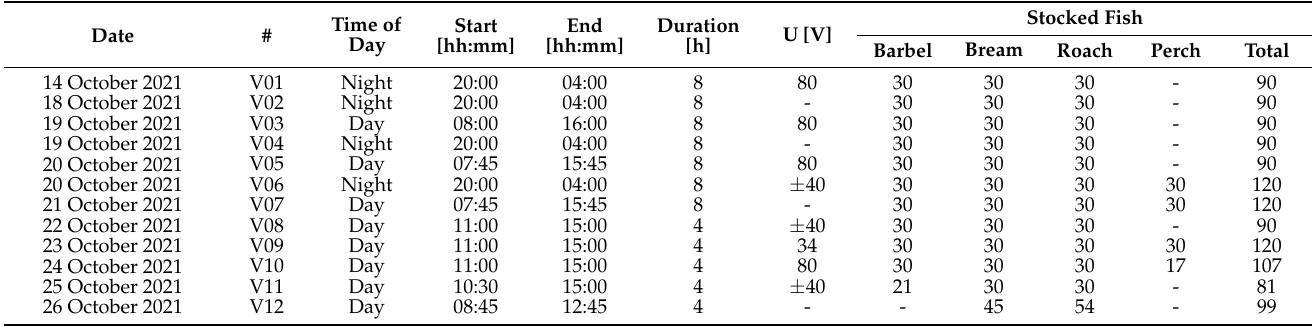
Table A1. Conducted trials including main parameters, date, trial number, time of day, start and end-time, duration, treatment conditions U (voltage) and stocked